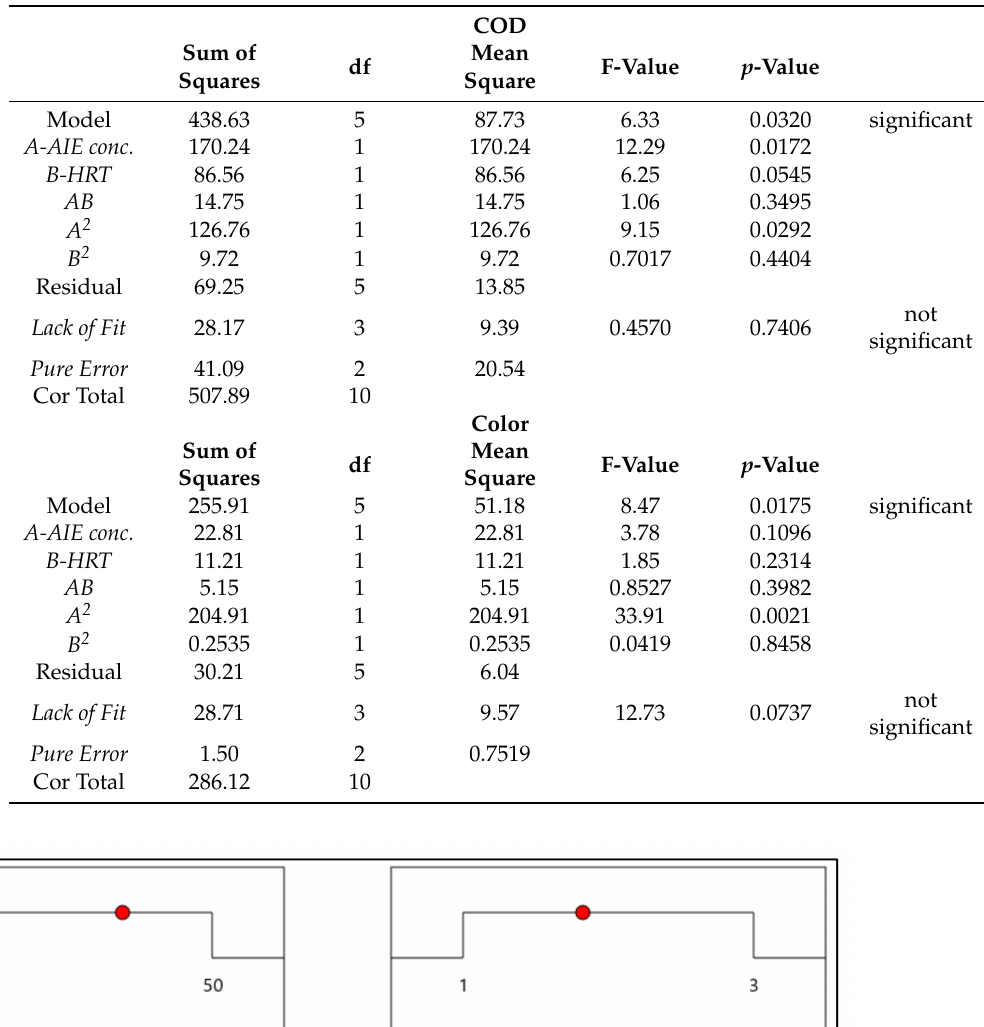
Table 4. ANOVA by RSM for COD and color removal efficiencies in CFBS.